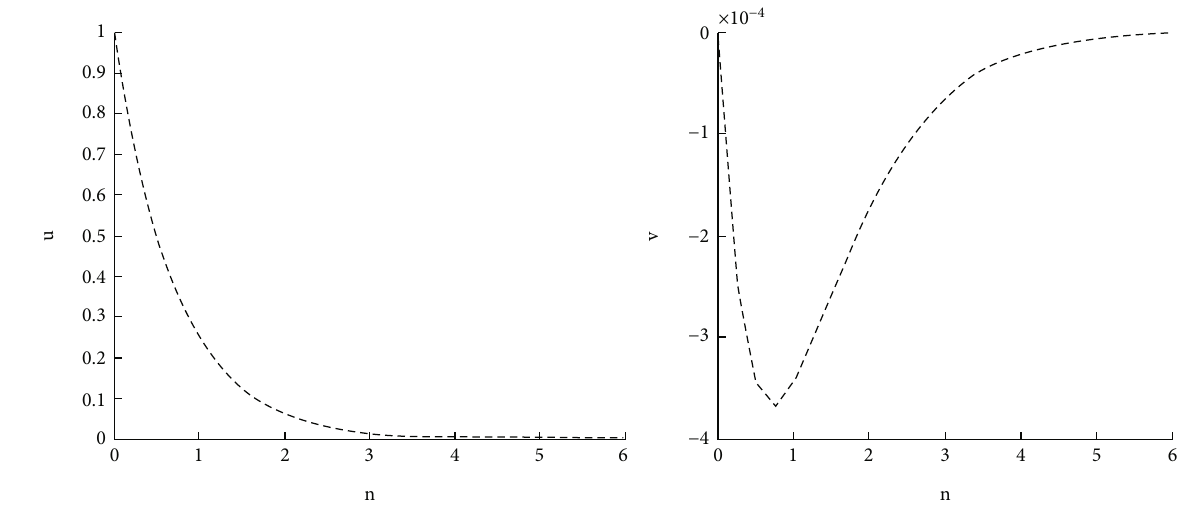
Figure 5: Approximate solution by hybrid